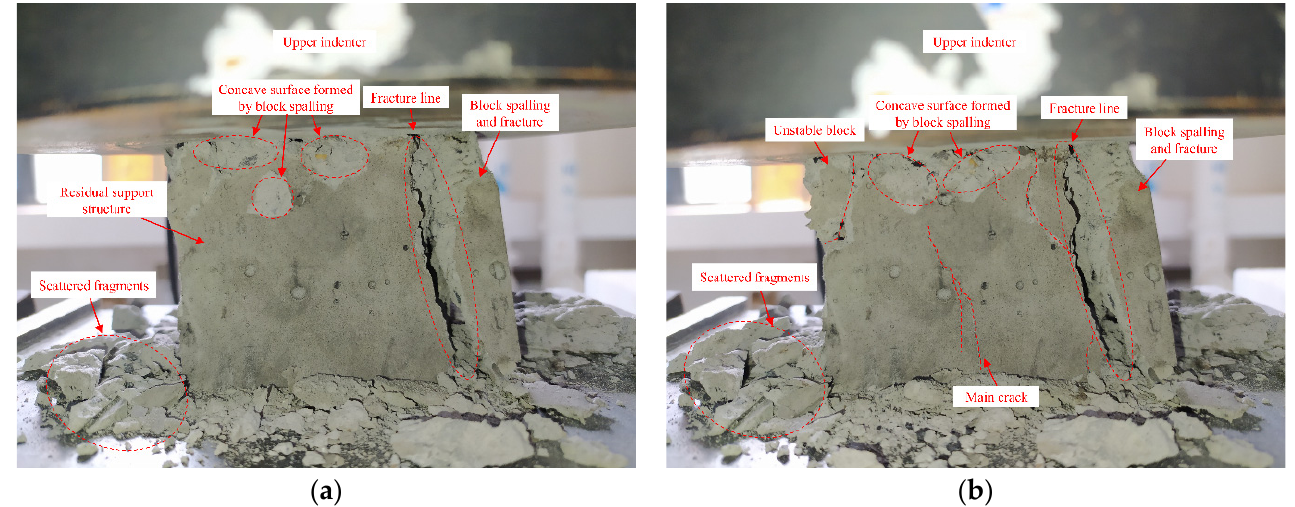
Figure 10. Failure morphology of specimens in experimental group A: ( a ) before the maximum rebound stress; ( b ) after the maximum rebound stress.